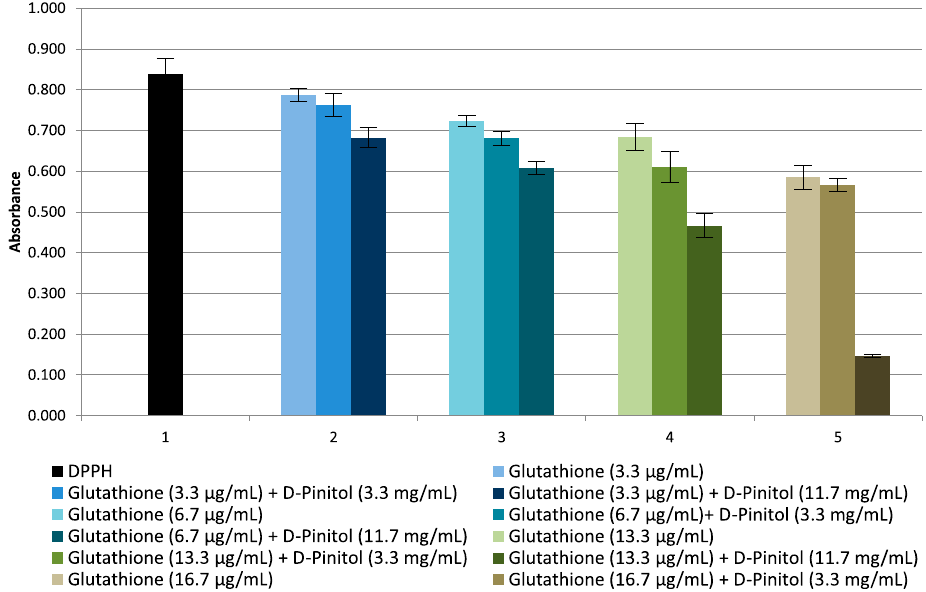
Figure 4. Changes in absorbance of glutathione and its mixture with D -pinitol (standard) at different concentration levels.